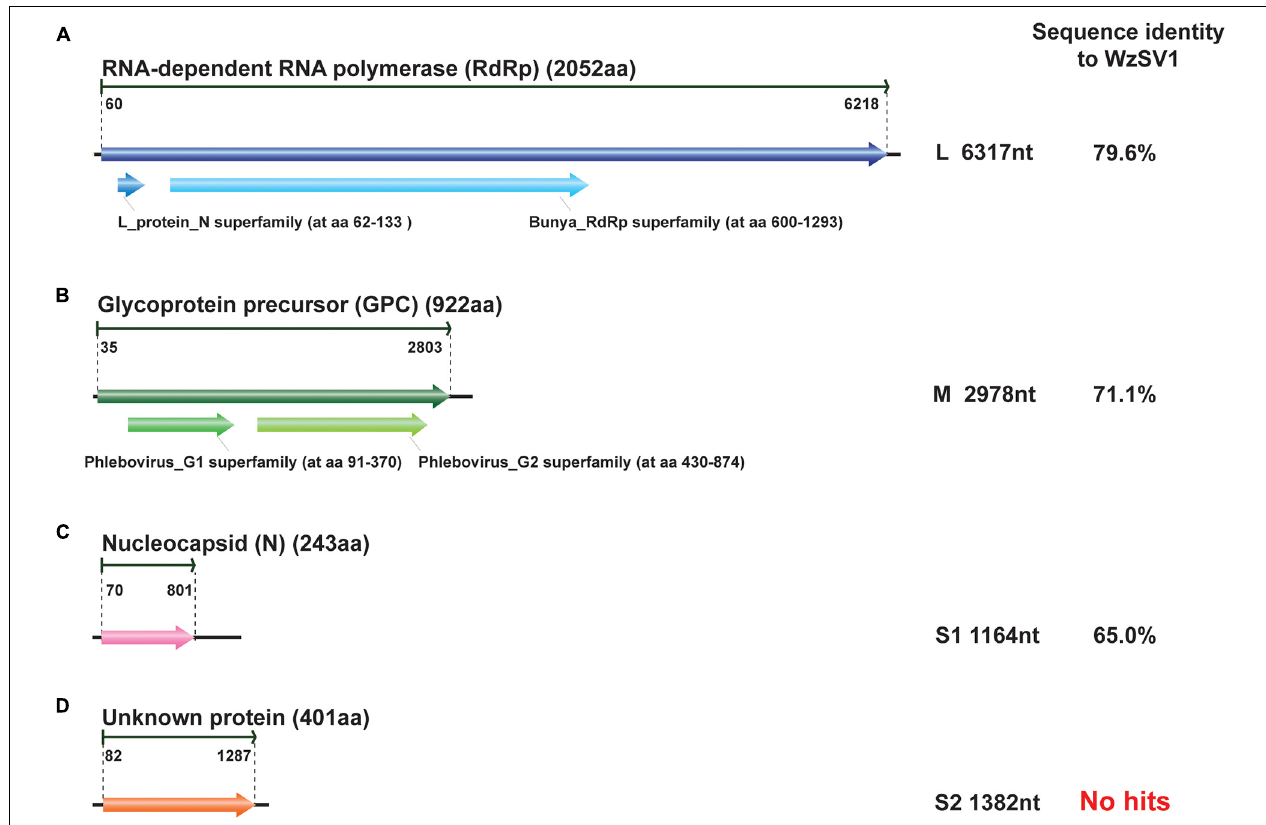
FIGURE 2 | Schematic presentation of the genomic RNA segments and conserved domains of oriental wenrivirus 1 (OWV1). The amino acid sequence identity of encoding protein was compared to that of W¯enzh¯ou shrimp virus 1 (WzSV-1). The genomic structure was predicted using Geneious, and the conserved protein domains were predicted using